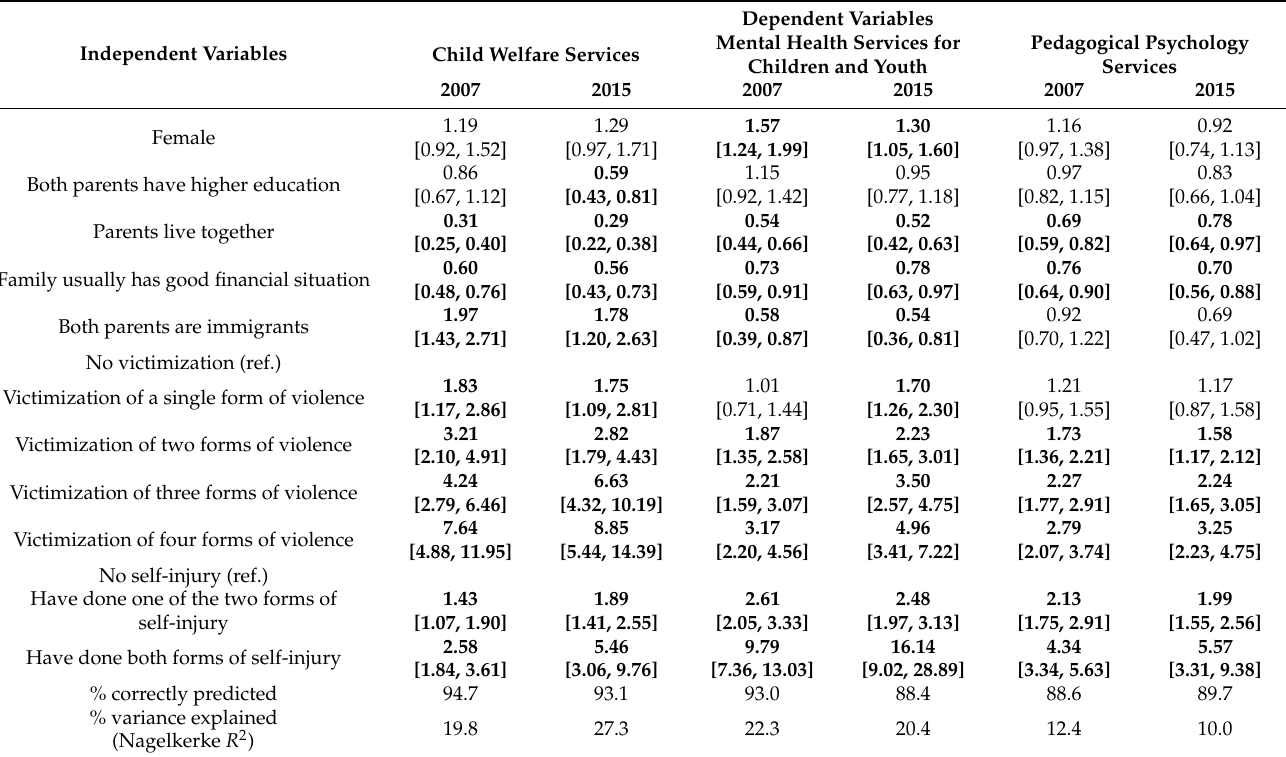
Table 3. Logistic regression of background variables, victimization of violence, and self-injury behaviors in relation to young people’s access to three support systems (ExpB odds ratios (95%CI for